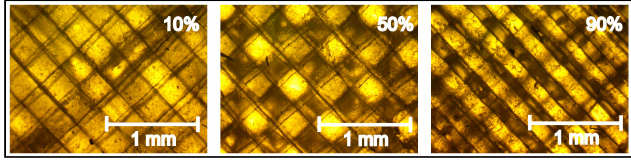
Figure 7. Microscope images of rectangular infill pattern (10%, 50% and 90% infill